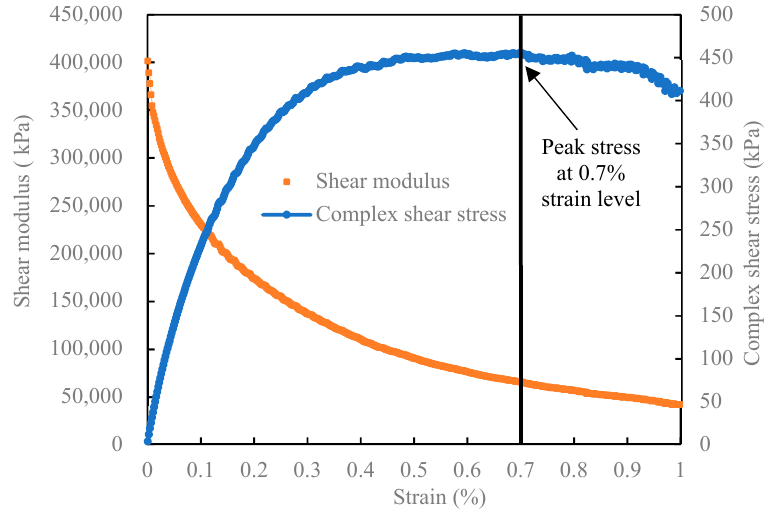
Figure 3. A best-fit straight line plotting with log ω and log G’ ( ω ).